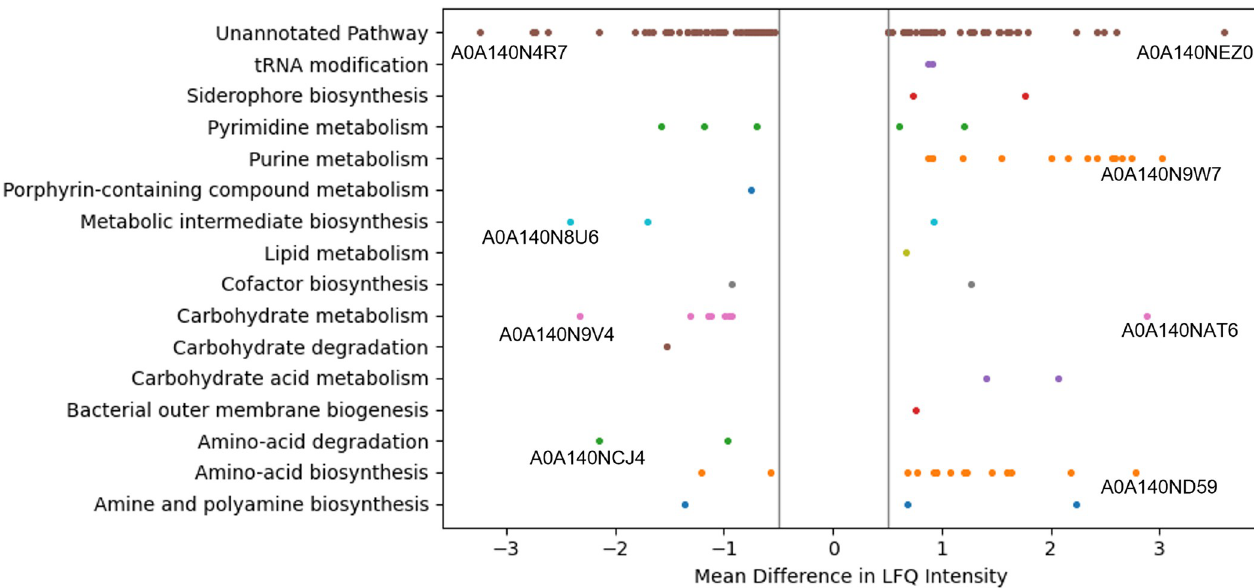
Fig 4. Pool-table plot of the proteomic analysis of the significantly dysregulated proteins from the sample condition of CHOgro 1 with 2% glycerol supplementation. This graph was constructed using the Matplotlib library in Python. Significant upregulation of expression is shown to the right of the central threshold divider (-0.5 to 0.5), with significant downregulation to the left. Significance in this case was defined as having a mean difference in LFQ intensity compared to the baseline media of more than 0.5 in either direction after a student’s t-test and with an FDR of < 0.05. The top three pathway proteins and the top one unannotated pathway protein are labelled directly below their representative point, for both up- and down-regulated.